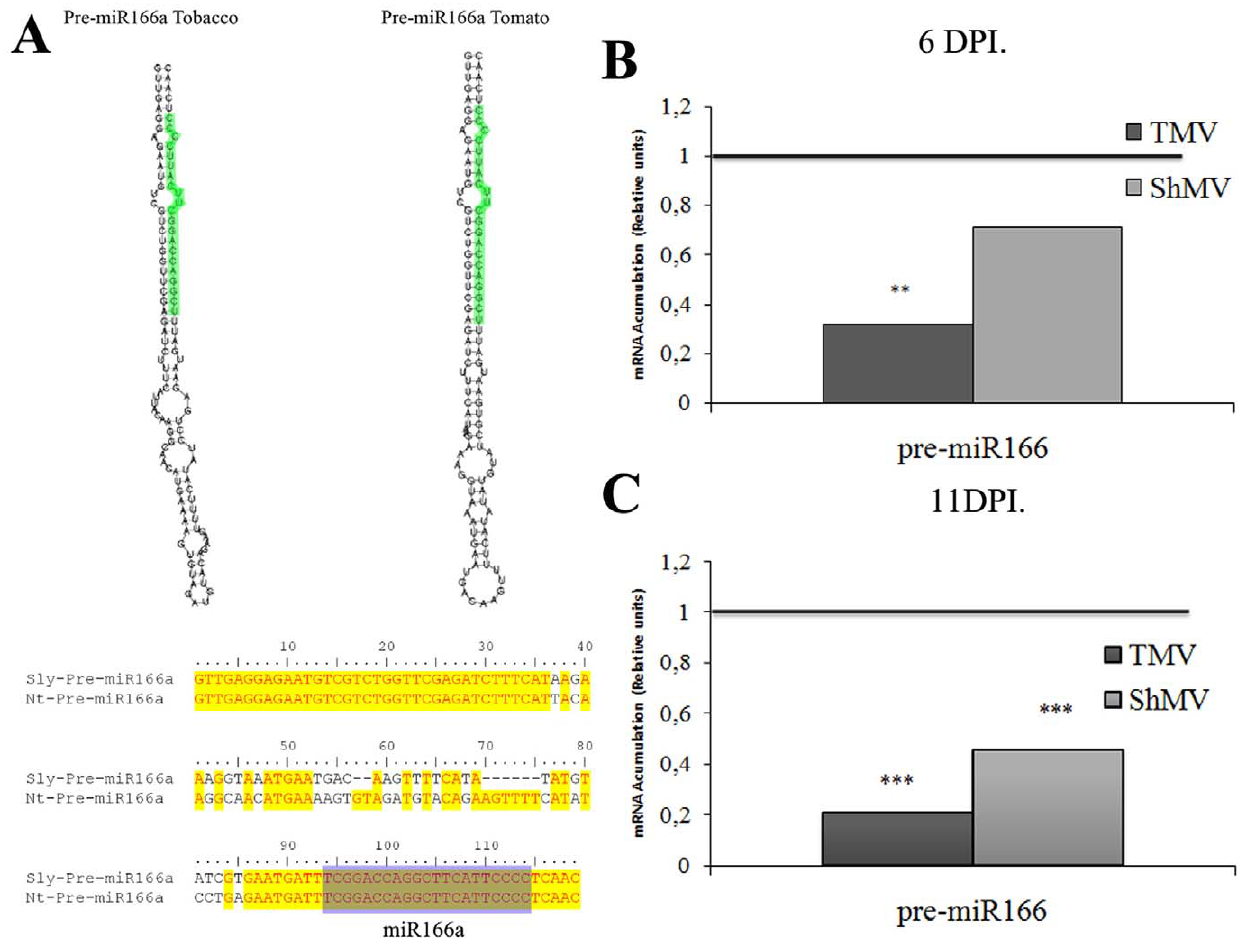
Figure 7. Pre-miRNA166 is reduced after virus infection. A ) Predicted fold-back secondary structures of tobacco and tomato miRNA166a precursors as determined by the RNAfold program. Mature miRNA sequences are highlighted in green. Clustal alignment between Pre-miRNA166a sequences from tobacco and tomato. ( BC ) Pre-miRNA166a qPCR quantification in plants infected with TMV or ShMV, ( B ) 6 dpi and ( C ) 11 dpi. ** means p-value , 0,05 and *** means p-value ,